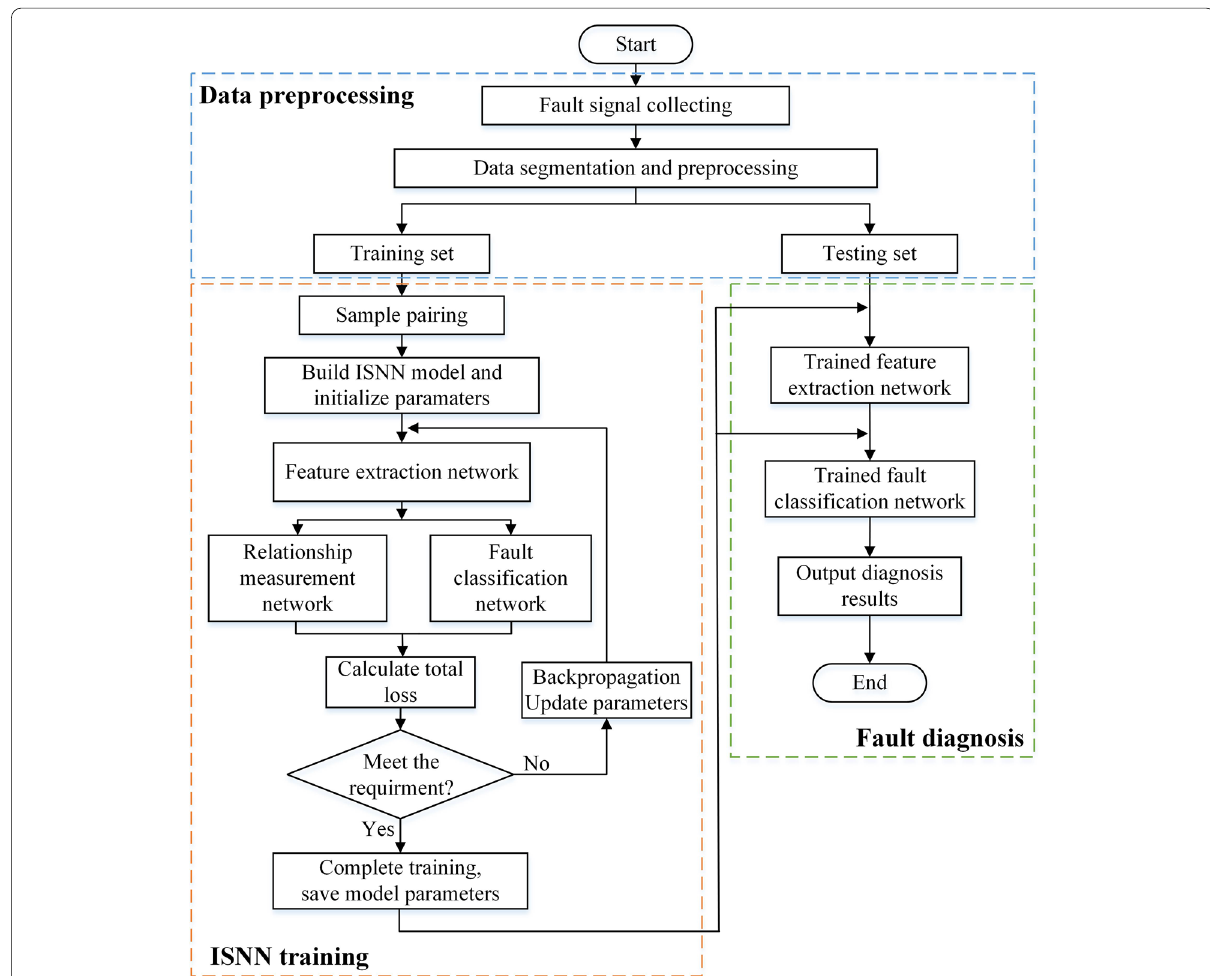
Fig. 3 Bearing fault diagnosis process.Based on the proposed ISNN model, this study designed a rolling bearing fault diagnosis process that included three steps: data preprocessing, ISNN training, and fault